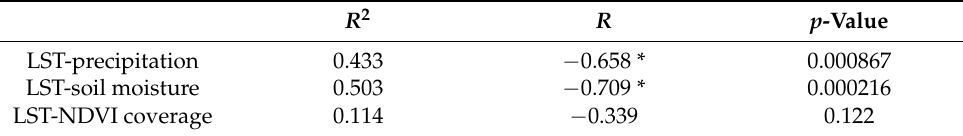
Table 2. The correlation ( R ) and determination ( R 2 ) coefficients and p -value for relationships between LST, precipitation, soil moisture, and vegetation coverage in Afghanistan in the period 2000–2021 calculated using the linear regression method.